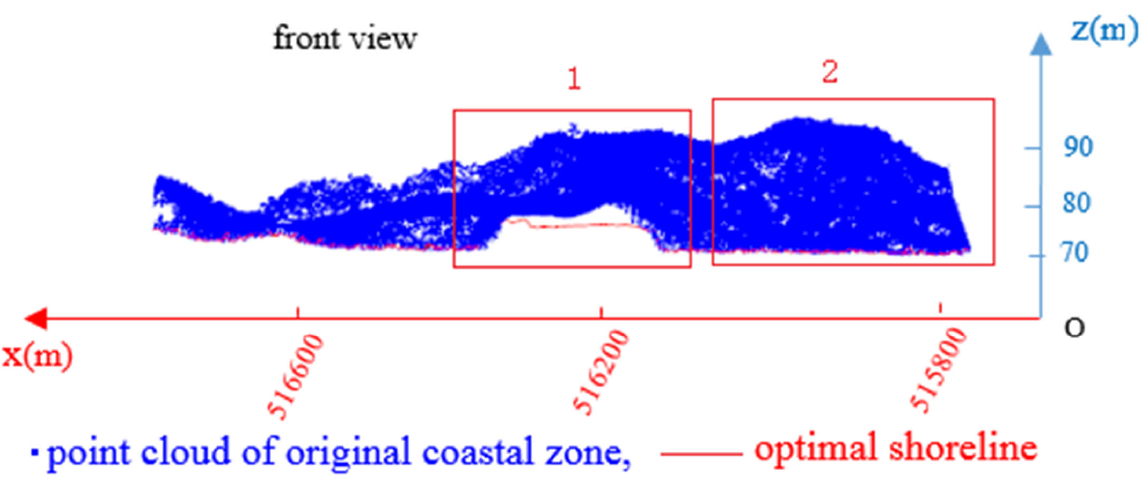
Figure 13. The superimposed display of the point cloud of integrated coastline and coastal zone. To analyze the generated coastline in greater detail, Areas 1 and 2 in Figure 13 are enlarged and displayed in Figure 14a,b, respectively.